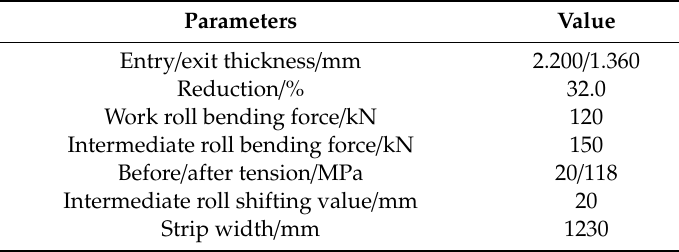
Table 2. 1420mmUCM reversible mill rolling parameters.